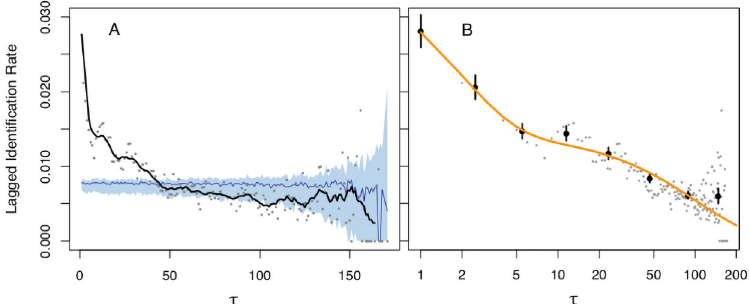
Fig 2. Lagged Identification Rate (LIR) of humpback whales in the Kitimat Fjord System. Left : Grey dots represent the LIR calculated for each time lag ( τ , in days) tested. Black line is the running mean of LIR (window = 10 days, first point forced to the τ = 1). Blue line and shaded area represent the median and 95% confidence interval (2.5% and 97.5% quantiles), respectively, of the permutation tests (n = 100). Lags at which the running mean rises above the shaded area indicate significant patterns in residency behavior. Right : Best-fitting SOCPROG model of LIR (note log scale). Points with standard errors (n = 100 bootstraps) are lag-pooled calculations of the LIR, computed at τ = 2 0–8 . Orange line represents the best-fitting model (see S6 Table in S1 File).